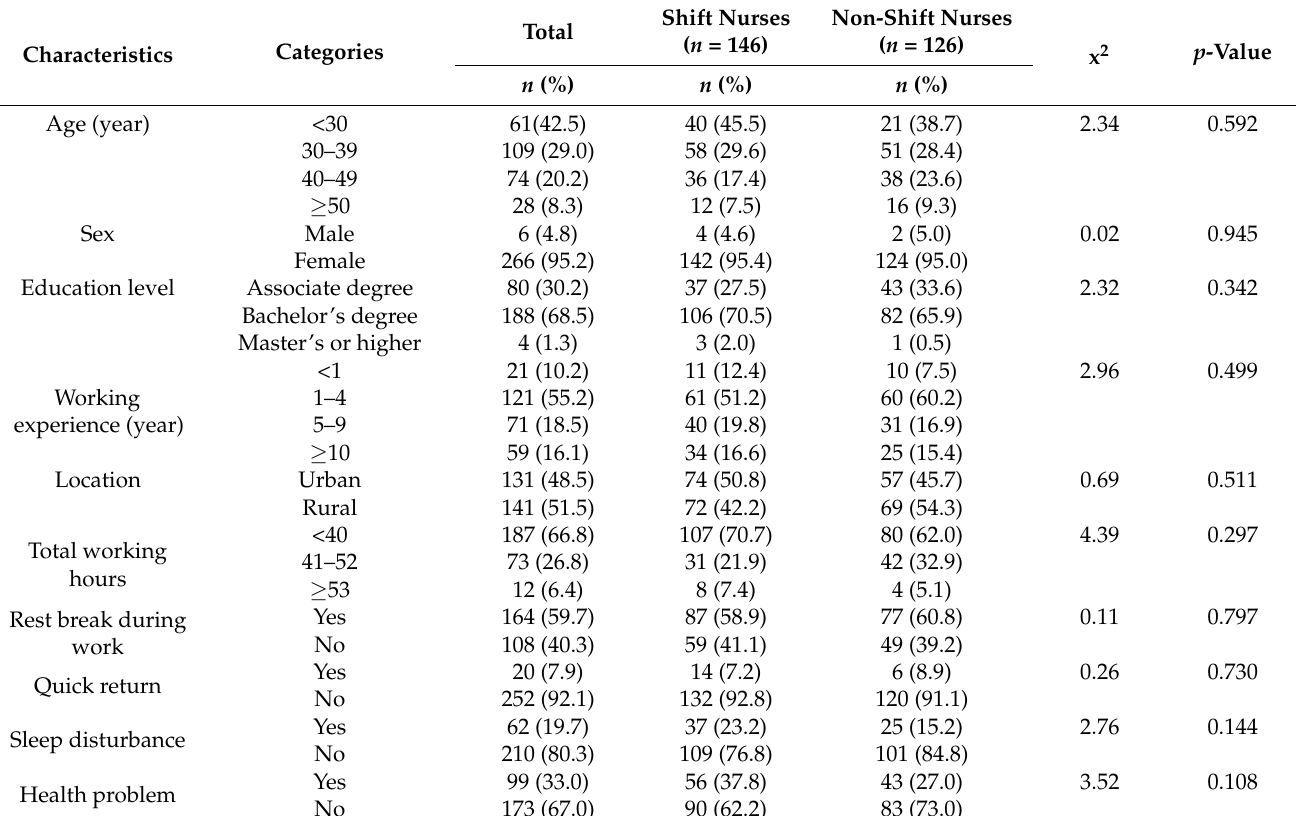
Table 1. Characteristics of the sample population by shift work ( n =